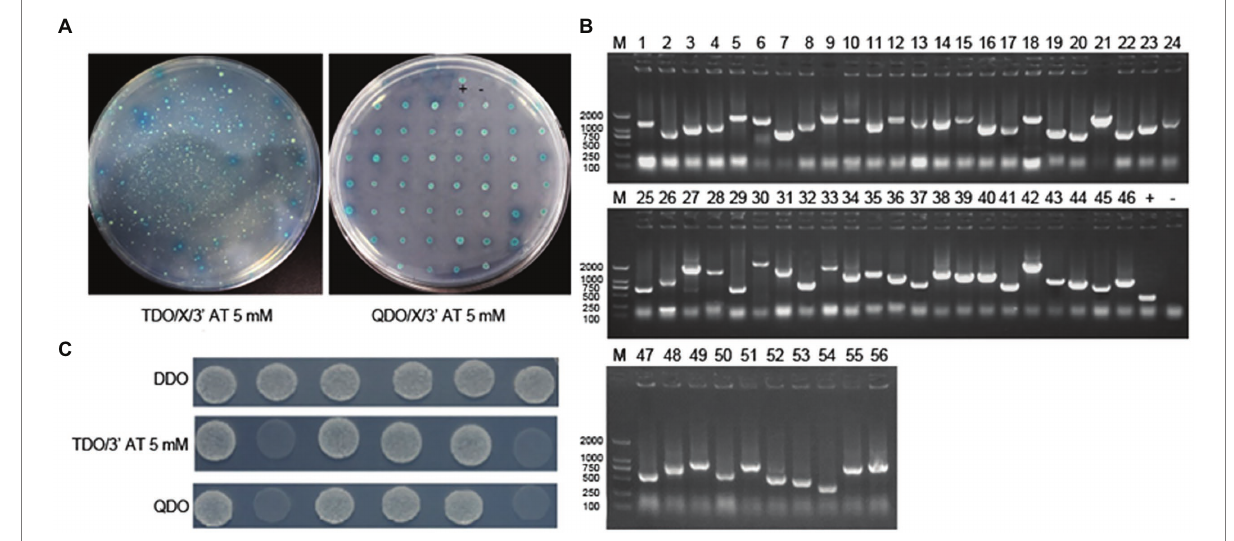
FIGURE 1 Identification of the interaction of ASFV p30 with host cellular proteins by DUALmembrane yeast two-hybrid system. (A) Co-transform bait and prey plasmid into NMY51, coat TDO/X/3 ′ AT 5 mM plate, pick blue colonies, and coat QDO/X/3 ′ AT 5 mM plate to further screen positive clones. (B) Agarose gel electrophoresis of PCR products of positive clone colonies. 1–53: PCR product; +: positive control (PCR using PPR3-N as template), − : negative control (PCR using water as template). (C) pBT3-N-CP204L (bait plasmid) was verified point-to-point with pPR3-N-Dab2 and pPR3-N-OAS1 (prey plasmid). 1: pBT3-N-CP204L and pOst1-NubI (functional verification); 2: pBT3-N-CP204L and pPR3-N (self-activation); 3: pBT3-N-CP204L and pPR3-N-Dab2 (experimental group); 4: pBT3-N-CP204L and pPR3-N-OAS1 (experimental group); +: pTSU2-APP and pNubG-Fe65 (positive control group); − : pTSU2-APP and PPR3-N (negative control